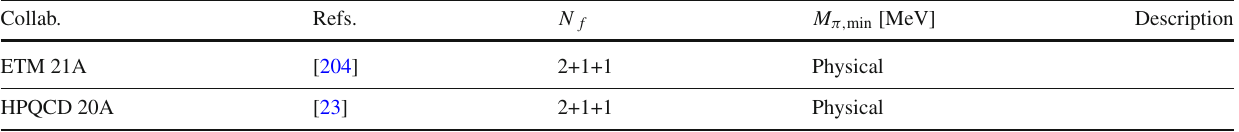
Table 89 Chiral extrapolation/minimum pion mass in the determinations of m c with N f = 2 + 1 + 1 quark flavours Collab.